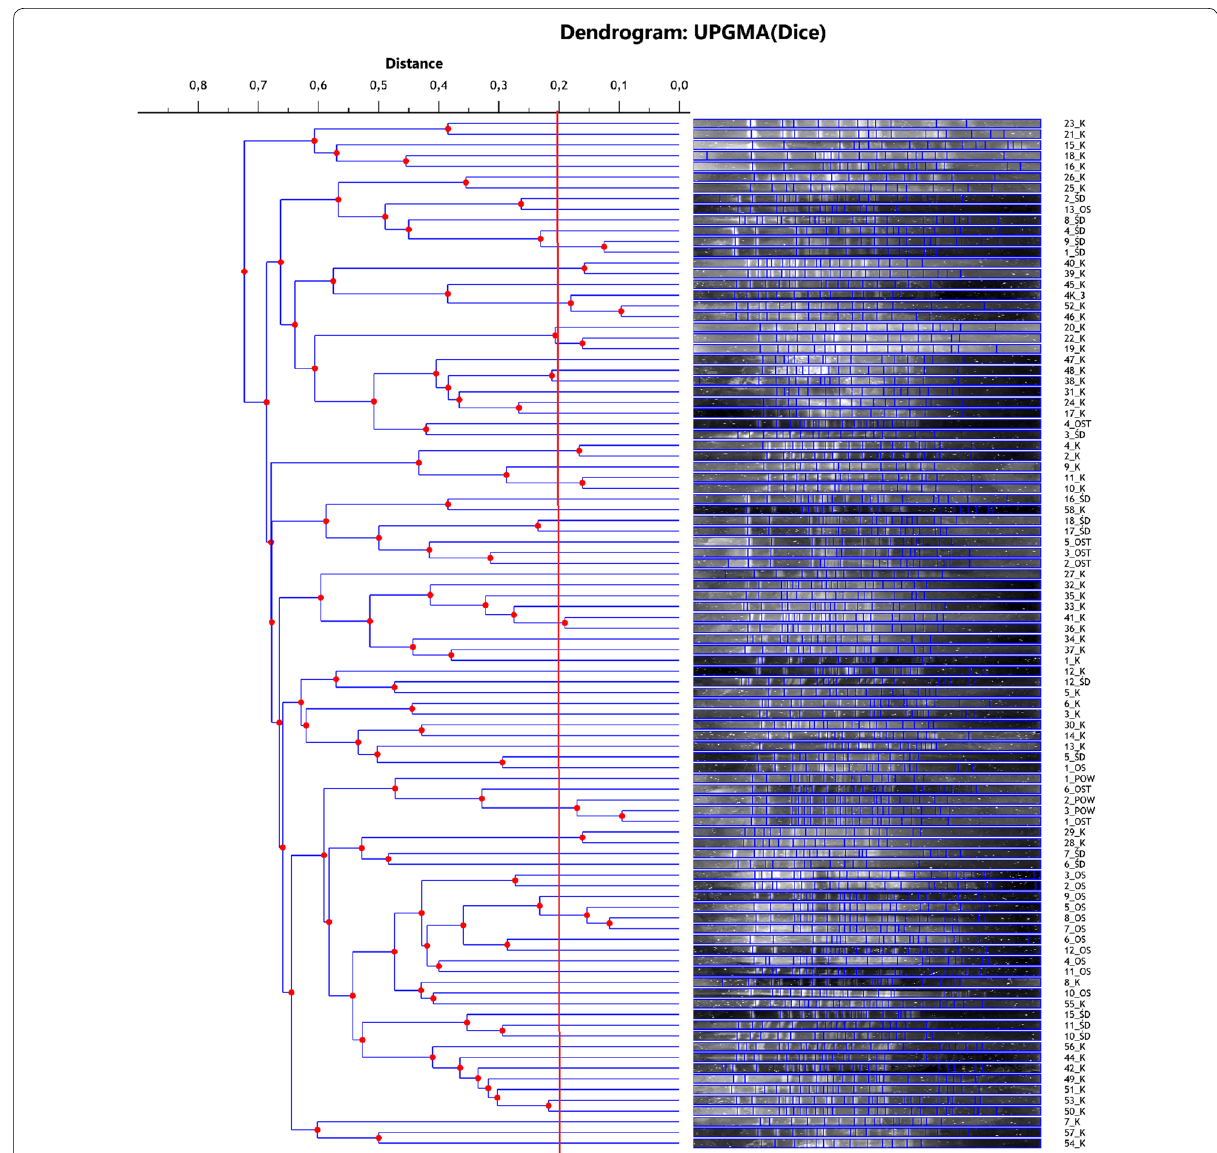
Fig. 1 Dendrogram of ApaI‑PFGE cluster analysis of 96 L. monocytogenes isolates with sample identification data. 1_K‑58_K, clinical samples; 1_ OS‑13_OS; 1_ŚD‑18_ŚD;1_OSTAB‑6_OSTAB; 1_POW‑3_POW, environmental